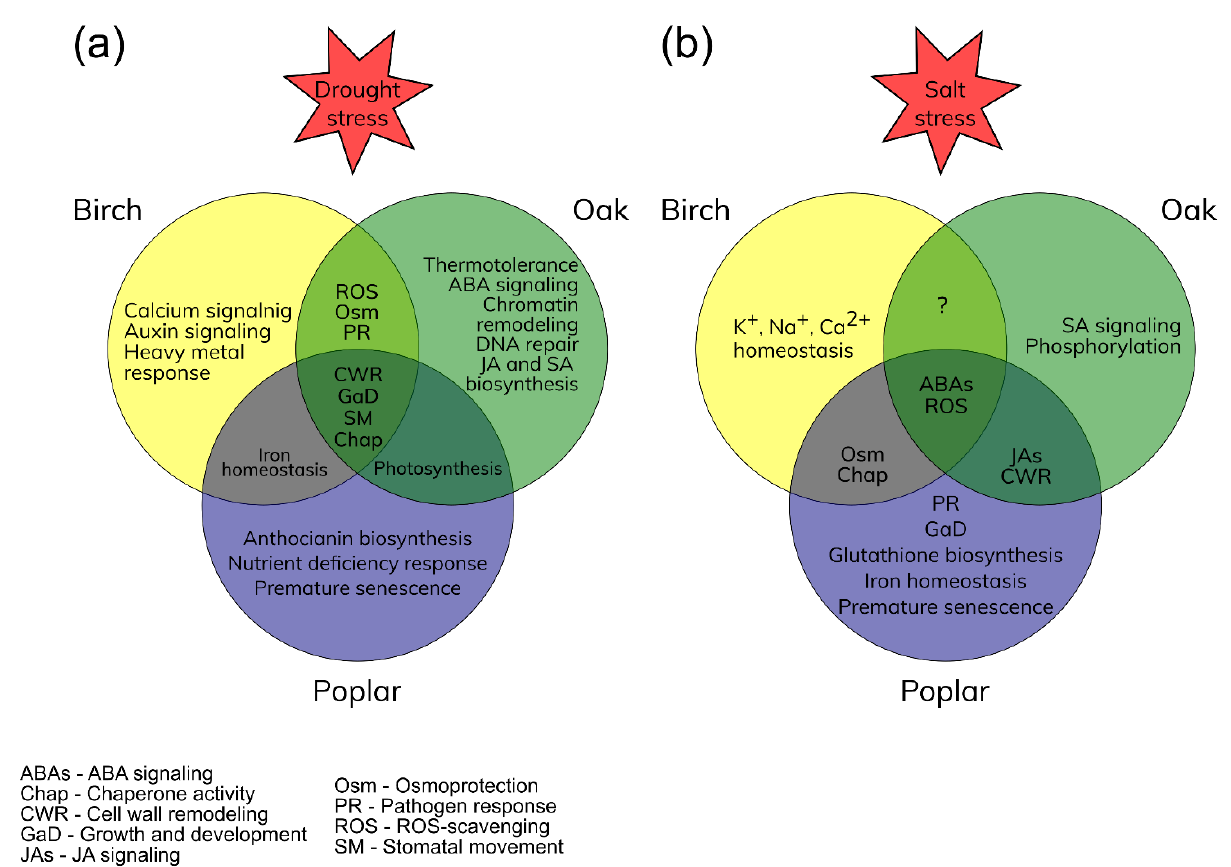
Figure 1. Main responses of birches, oaks, and poplars to drought ( a ) and salt ( b ) stress conditions. Overlapping circle parts represent the common stress